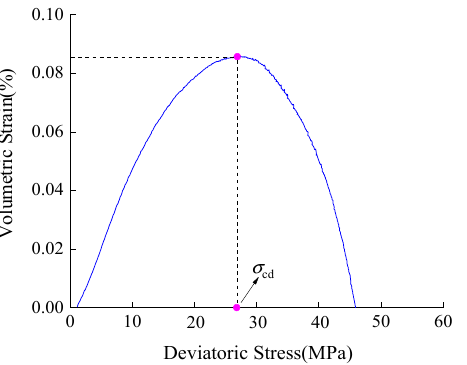
Figure 5. The σ cd is determined based on volume strain–deviatoric stress curve.